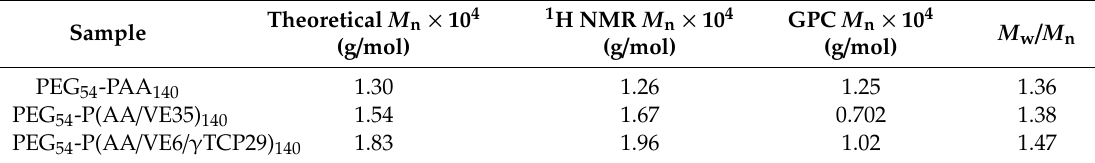
Table 1. Number-average molecular weight ( M n ) and M n distribution ( M w / M n ).